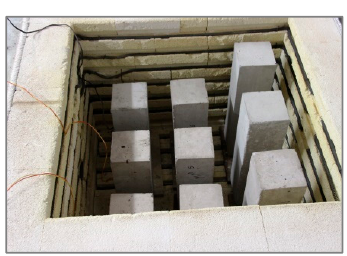
Figure 5. Electric furnace.